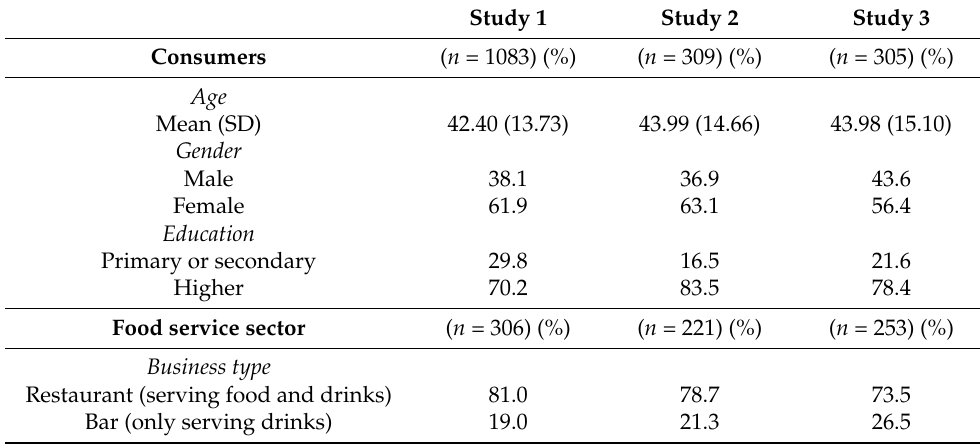
Table 2. Socio-demographic characteristics of the sample per study.